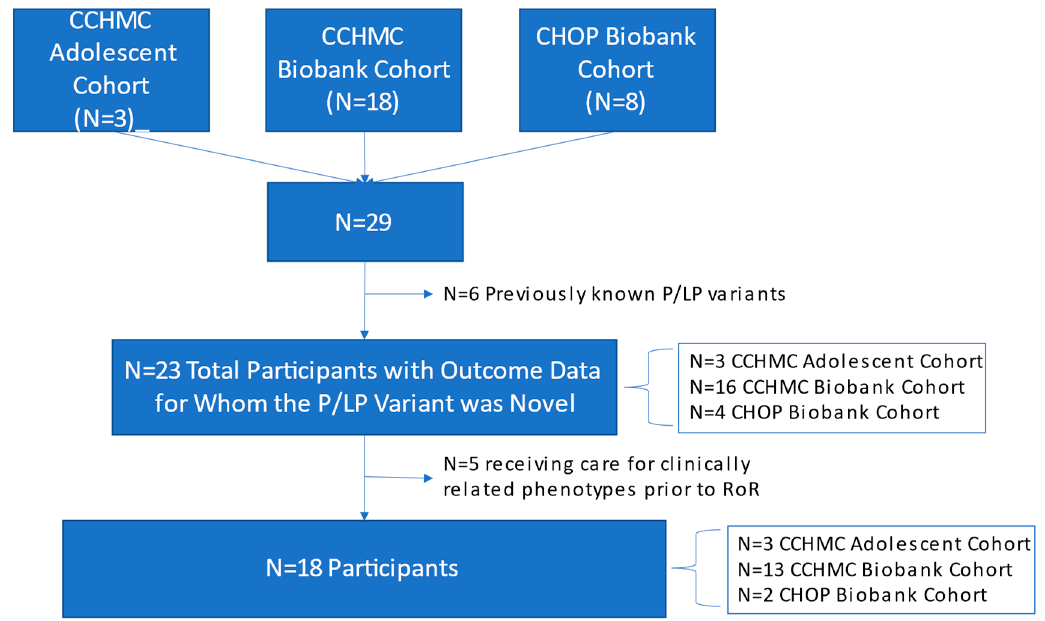
Figure 1. Participants with P/LP Results and Outcome Data by Site and Cohort.